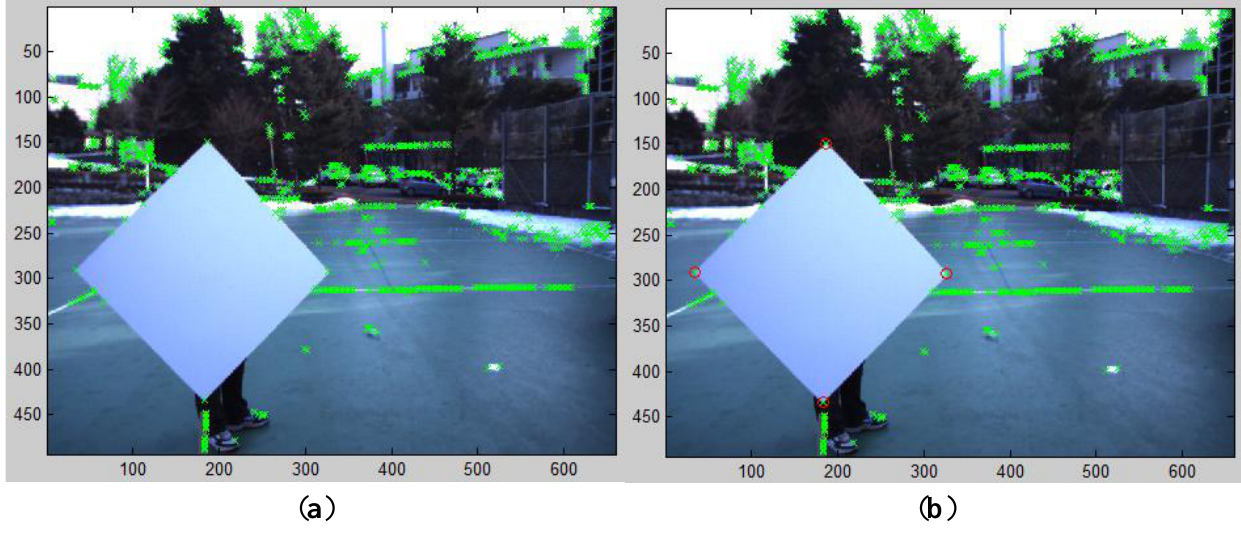
Figure 14. Lasers scans on the diamond board: ( a ) 3D points on the diamond board surface; ( b ) estimated side lines and their intersections (red dots) as estimated 3D